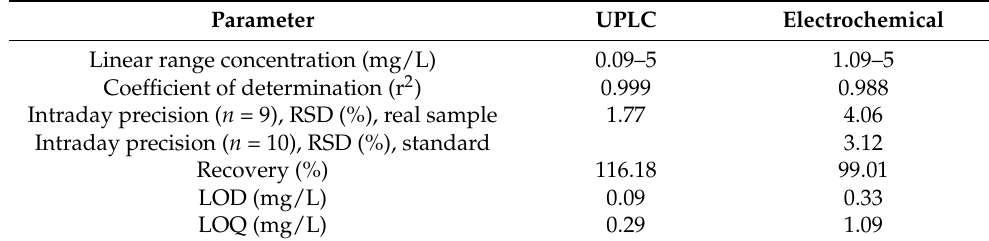
Table 6. Method validation parameters for the determination of tryptophan in fruit